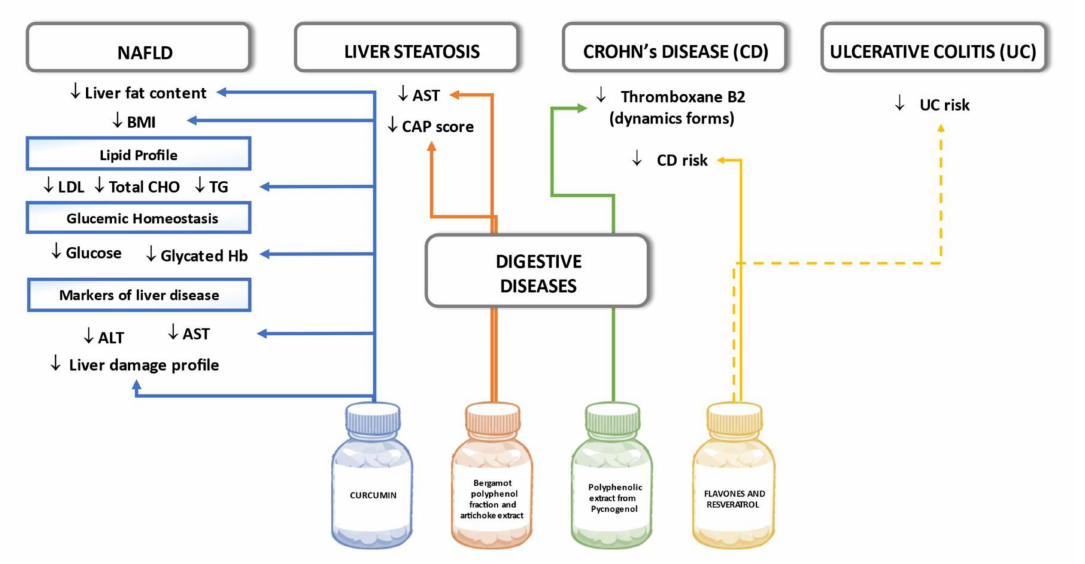
Figure 8. Effects of polyphenols on digestive diseases in human studies. Dashed lines indicate lack of significant